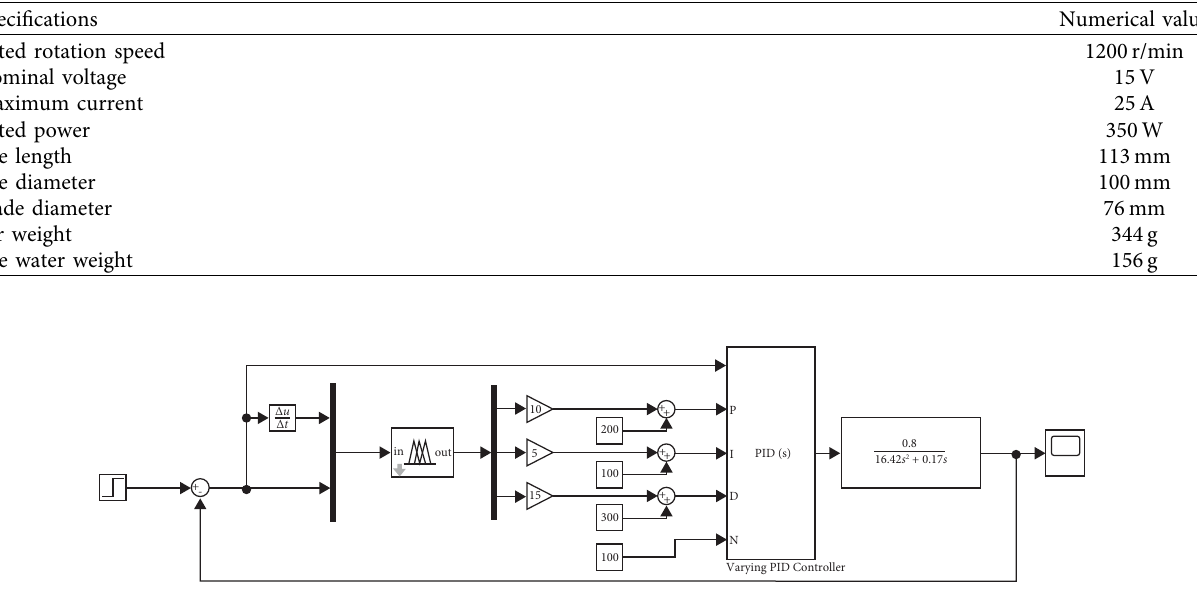
Table 4: Propeller specifcations of the underwater vehicle.